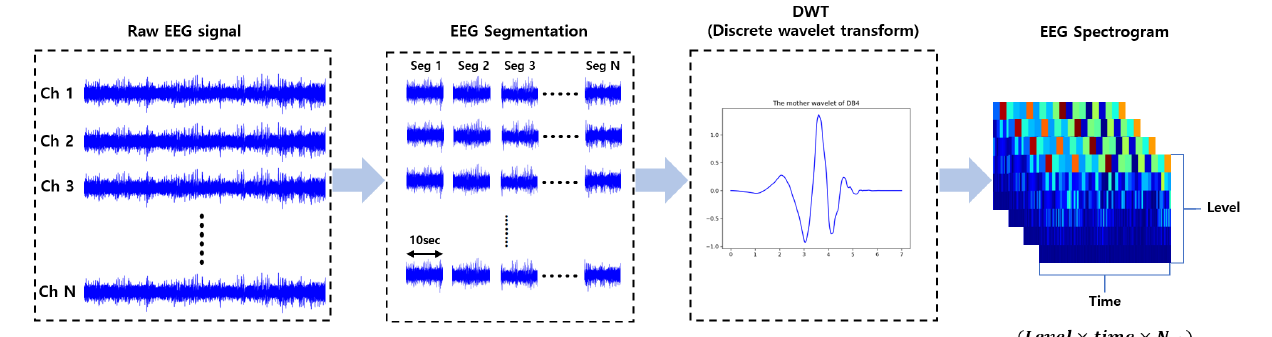
Figure 4. The process of converting raw EEG signals into time-frequency images using DWT.